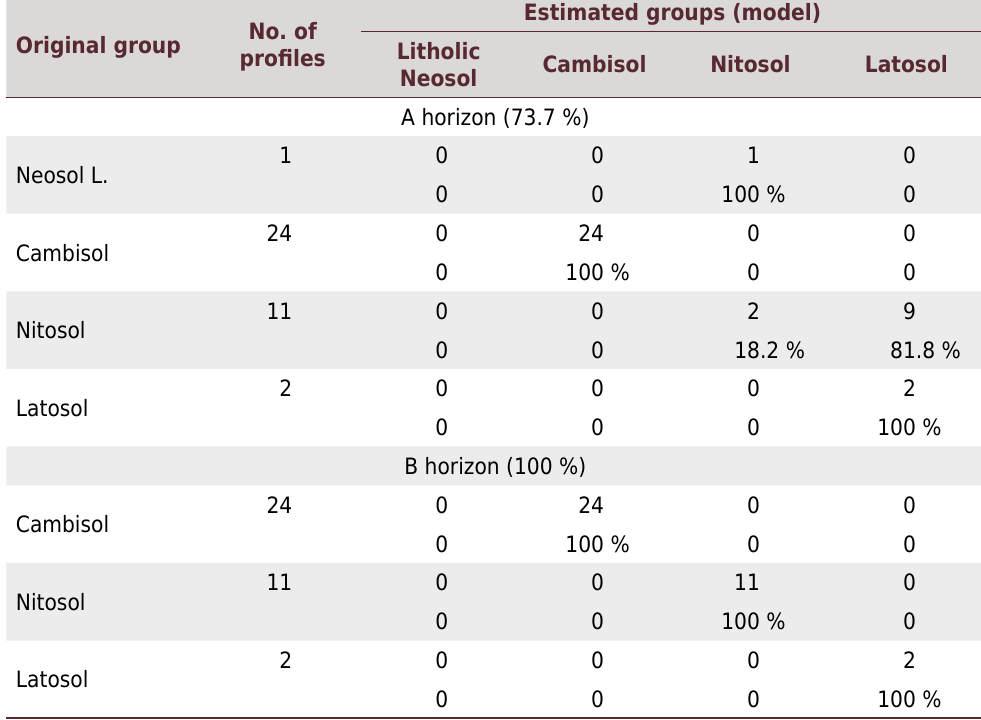
Figure 3. Dispersion of the canonical coefficients of the variables in relation to the soil classes in the B horizon.